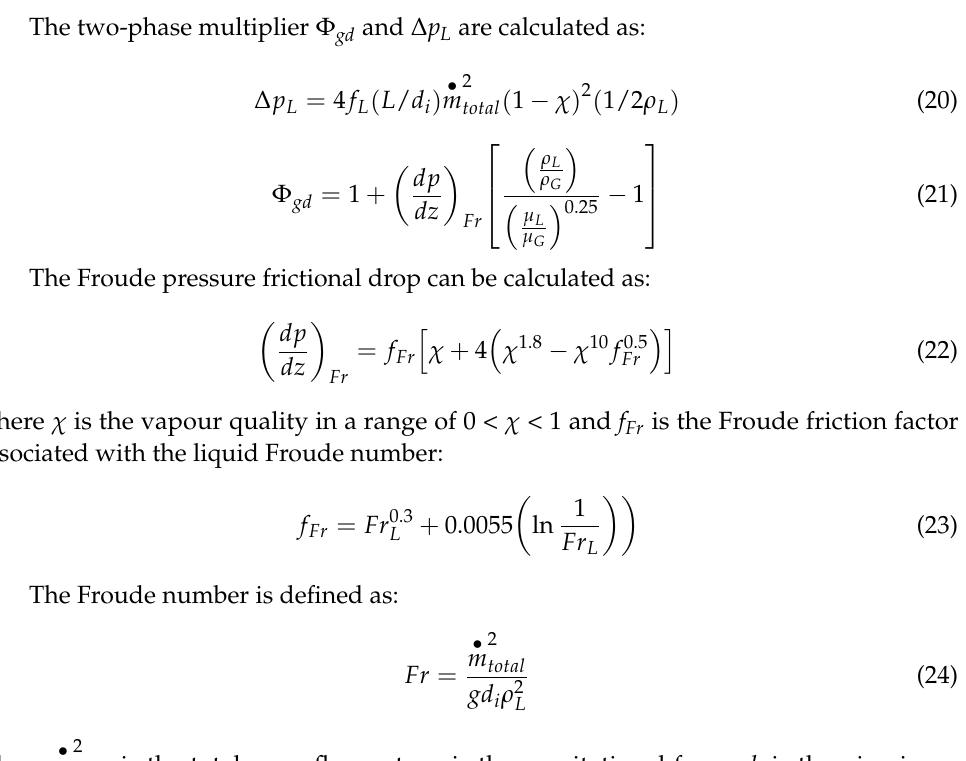
Figure 17. Comparison of the data fitting results for present CFD predictions and experimental measurements of Schubring and Shedd [10] using the GrÖnnerud correlation. ( d i = 8.8 mm, u sl > 0.07 m/s).